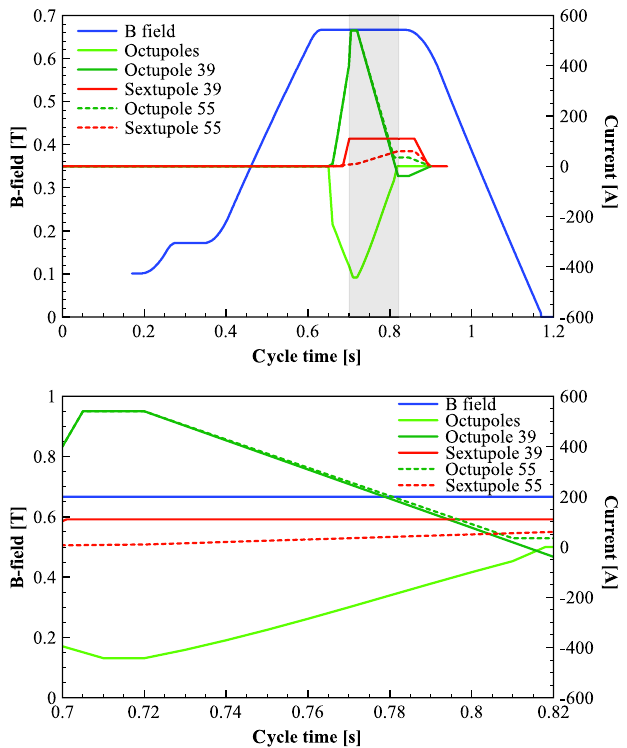
FIG. 2. Overview of the MTE gymnastic (upper). The mag- netic cycle is shown together with the evolution of the current for the nonlinear elements used for generating the stable islands and correcting the nonlinear coupling. The shaded area represents the region where the transverse splitting takes place: the closeup of this region is shown in the lower plot. The numbers after the elements indicate the straight section in which they are installed.